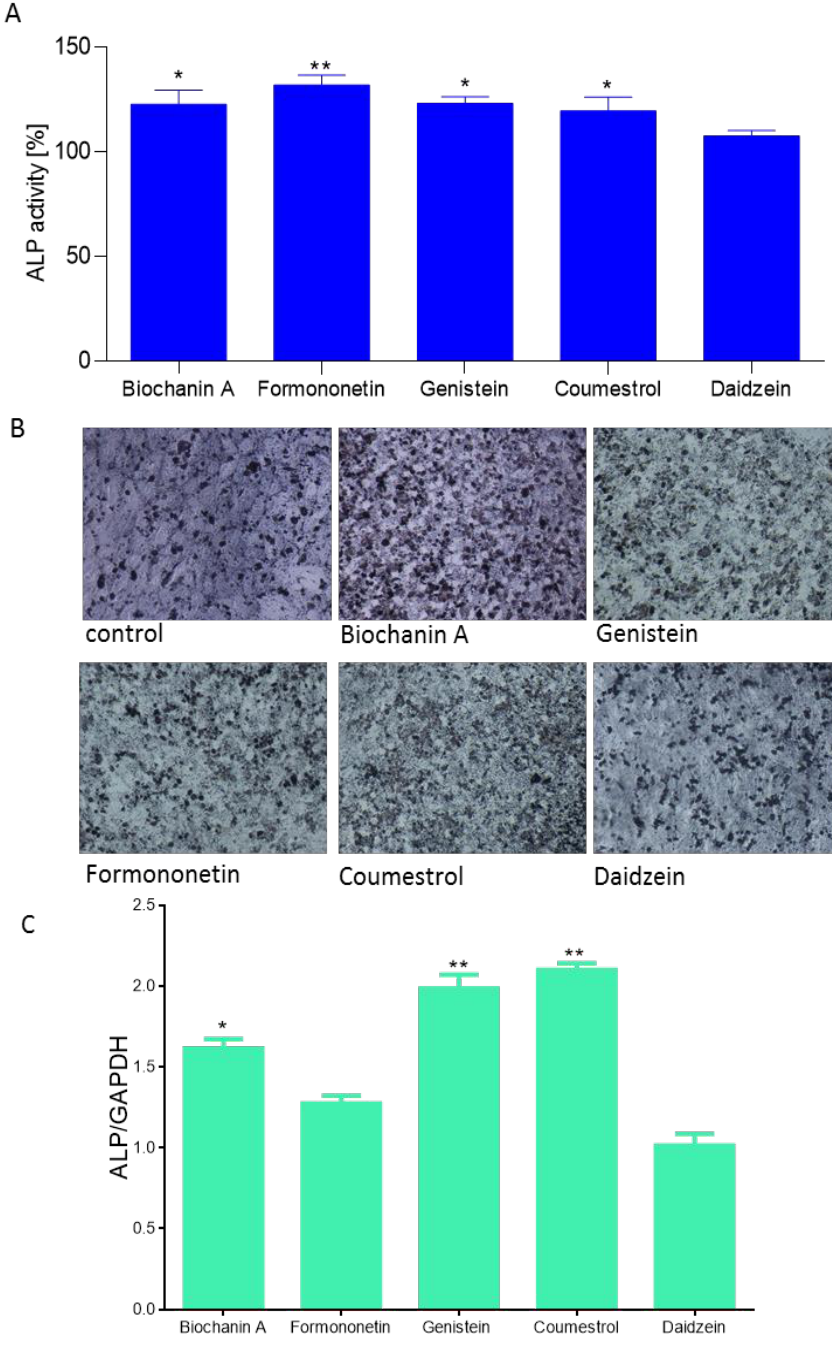
Figure 6. The influence of isoflavones on Saos-2 cells alkaline phosphatase (ALP) activity determined by p -nitrophenyl phosphate ( p NPP) assay after 14 days exposure. Control cells were not exposed to any compound but the vehicle; values are means ± standard deviations from at least three independent experiments ( n ≥ 15) ( A ); representative images of cells incubated in the presence of ALP substrate BCIP / NBT after treatment with isoflavones using Nikon TS100 Eclipse microscope (Japan), 200 × magnification ( B ); isoflavones as regulators of ALP expression gene quantified by real-time PCR and normalized using glyceraldehyde-3-phosphate dehydrogenase (GAPDH) as a reference gene ( n ≥ 3); ( C ); statistical significance was calculated versus control cells (untreated), statistical significance was calculated versus control cells (untreated), * p ≥ 0.05, ** p ≥ 0.01, *** p ≥ 0.001.